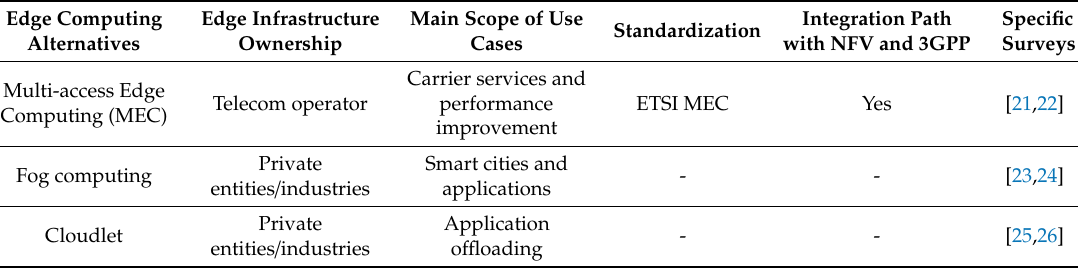
Table 1. Technological computing alternatives at the network